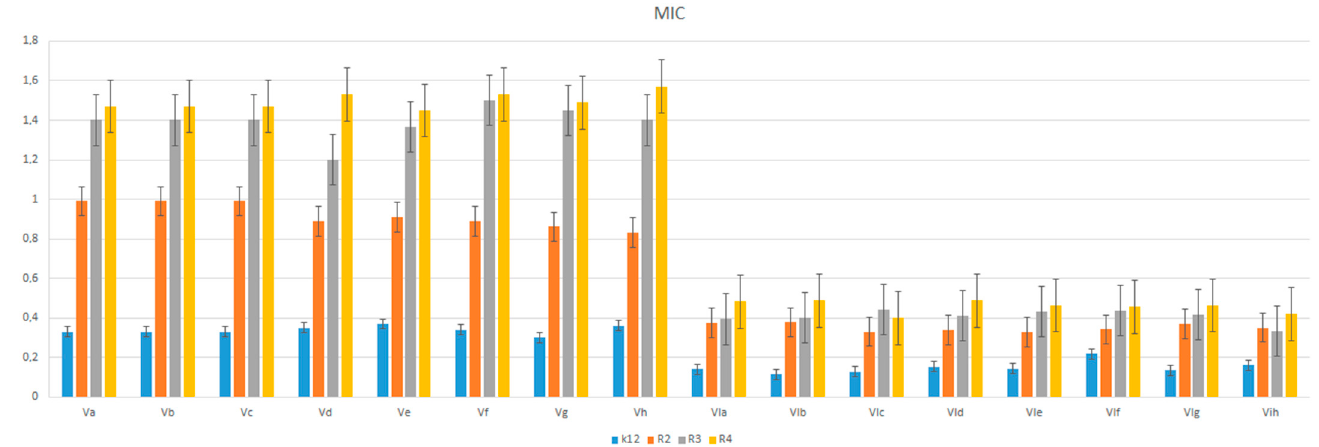
Figure 3. Minimum inhibitory concentration (MIC) of the phosphonate derivatives in model bacterial strains. The x -axis features compounds 1 – 16 used sequentially. The y -axis shows the MIC value in µ g/mL − 1 Investigated strains of E. coli K12 as control (blue), R2 strains (orange), R3 strain (grey), and R4 strain (yellow). The y -axis shows the MBC value in µ g/mL − 1 . The order in which the compounds were applied to the plate is shown in Supplementary Materials Figure S1.